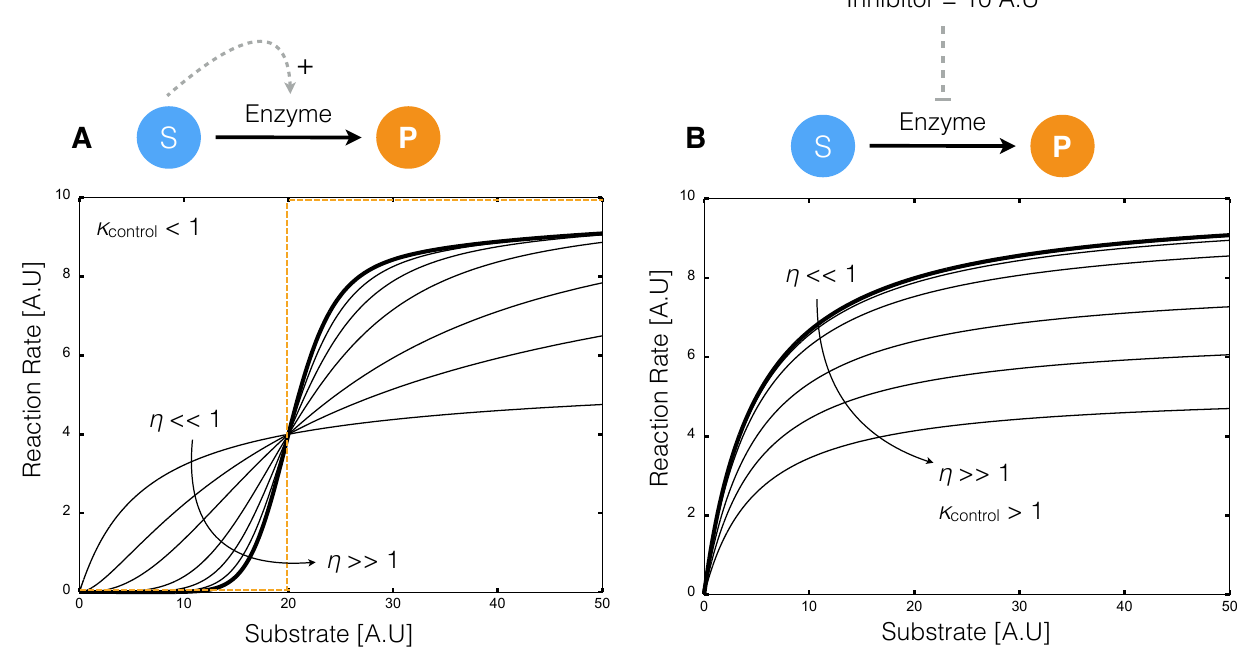
Figure 3. Kinetics of simple transformations in the presence of activation and inhibition. ( A ) The conversion of substrate S to product P by enzyme E was activated by S . For a fixed control gain parameter κ , the reaction rate approached a step for control increasing cooperativity control parameter η . For activation simulations κ = control